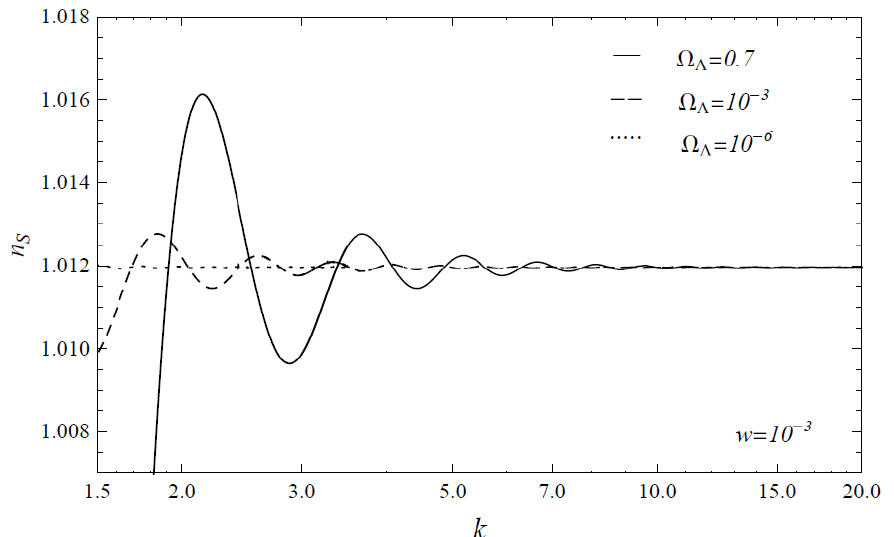
Figure 3. Numerical results for n S ( k ) in the presence of a cosmological constant. The solid line shows the result obtained using Ω Λ = 0.7, the dashed line for Ω Λ = 10 − 3 and the dotted line for Ω Λ = 10 6 . The oscillations become smaller for smaller Ω Λ , indicating that they arise because of the − presence of the cosmological